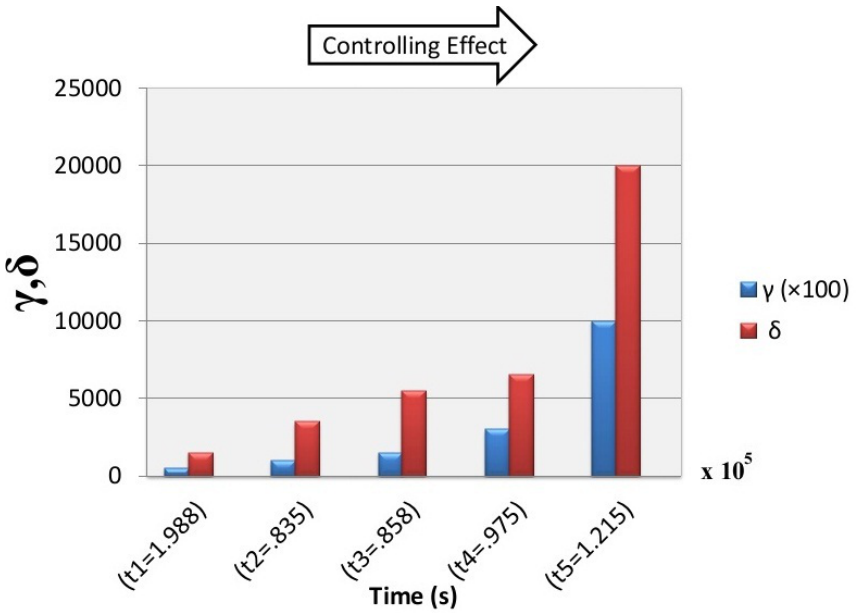
Figure 6. Effect of γ and δ at the same time. Spiking activity of post-synaptic neuron can be modulated.